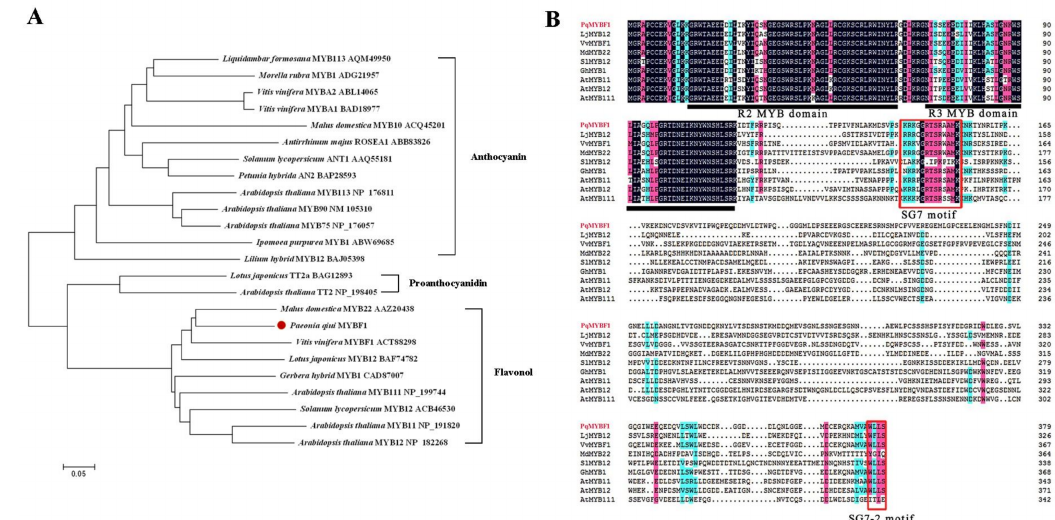
Figure 1. Phylogenetic analysis and sequence alignment of PqMYBF1 with other MYB proteins ( A ) Phylogenetic analysis of PqMYBF1 protein and MYB proteins from other species. Presumed functions of these MYB proteins are listed on the right side of the phylogenetic tree. PqMYBF1 is highlighted with a red dot. The neighbor-joining method with MEGA software was used to construct the phylogenic tree. Bootstrap values as a percentage of 1000 replicates are indicated at corresponding branch nodes. Scale bar represents the number of amino acid substitutions per site. ( B ) Sequence alignment of PqMYBF1 with MYB involved in flavonol synthesis. The black line indicates the positions of the R2 and R3 MYB domains. The red box shows the SG7 and SG7-2 motif. 2.2. PqMYBF1 Localizes to the Nucleus and Acts as a Transcriptional Activator ToinvestigatethesubcellularlocalizationofPqMYBF1, therecombinantvectorpCAMBIA2300-